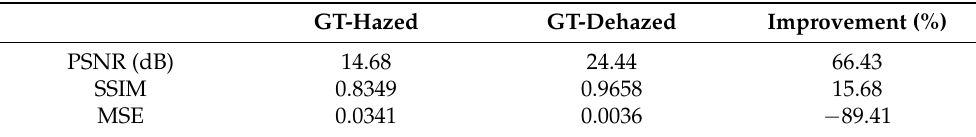
Table 3. Quantitative analysis of improvement using third row image from Figure 14. Table 2. Quantitative analysis of improvement using second row image from Figure 14.